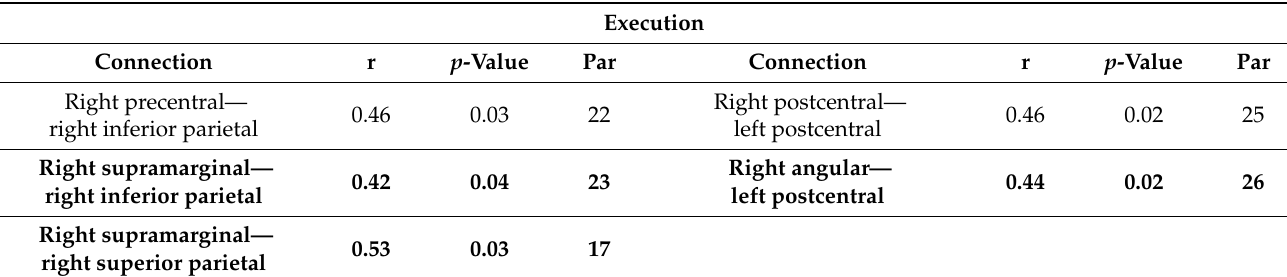
Figure 3. Correlations between functional connectivity and AQ score: ( a ) 5 connections with a significant correlation coefficient during Action-execution; ( b ) 13 connections with a significant correlation coefficient during Action-observation; and brain maps showing the location of connections with significant correlation coefficients ( c ) during action-execution; ( d ) during action-observation; ( e ) during both conditions. Table 2. Connections which have a significant correlation between connectivity in a condition and AQ score. Regions in bold: connections overlapped between the two conditions.